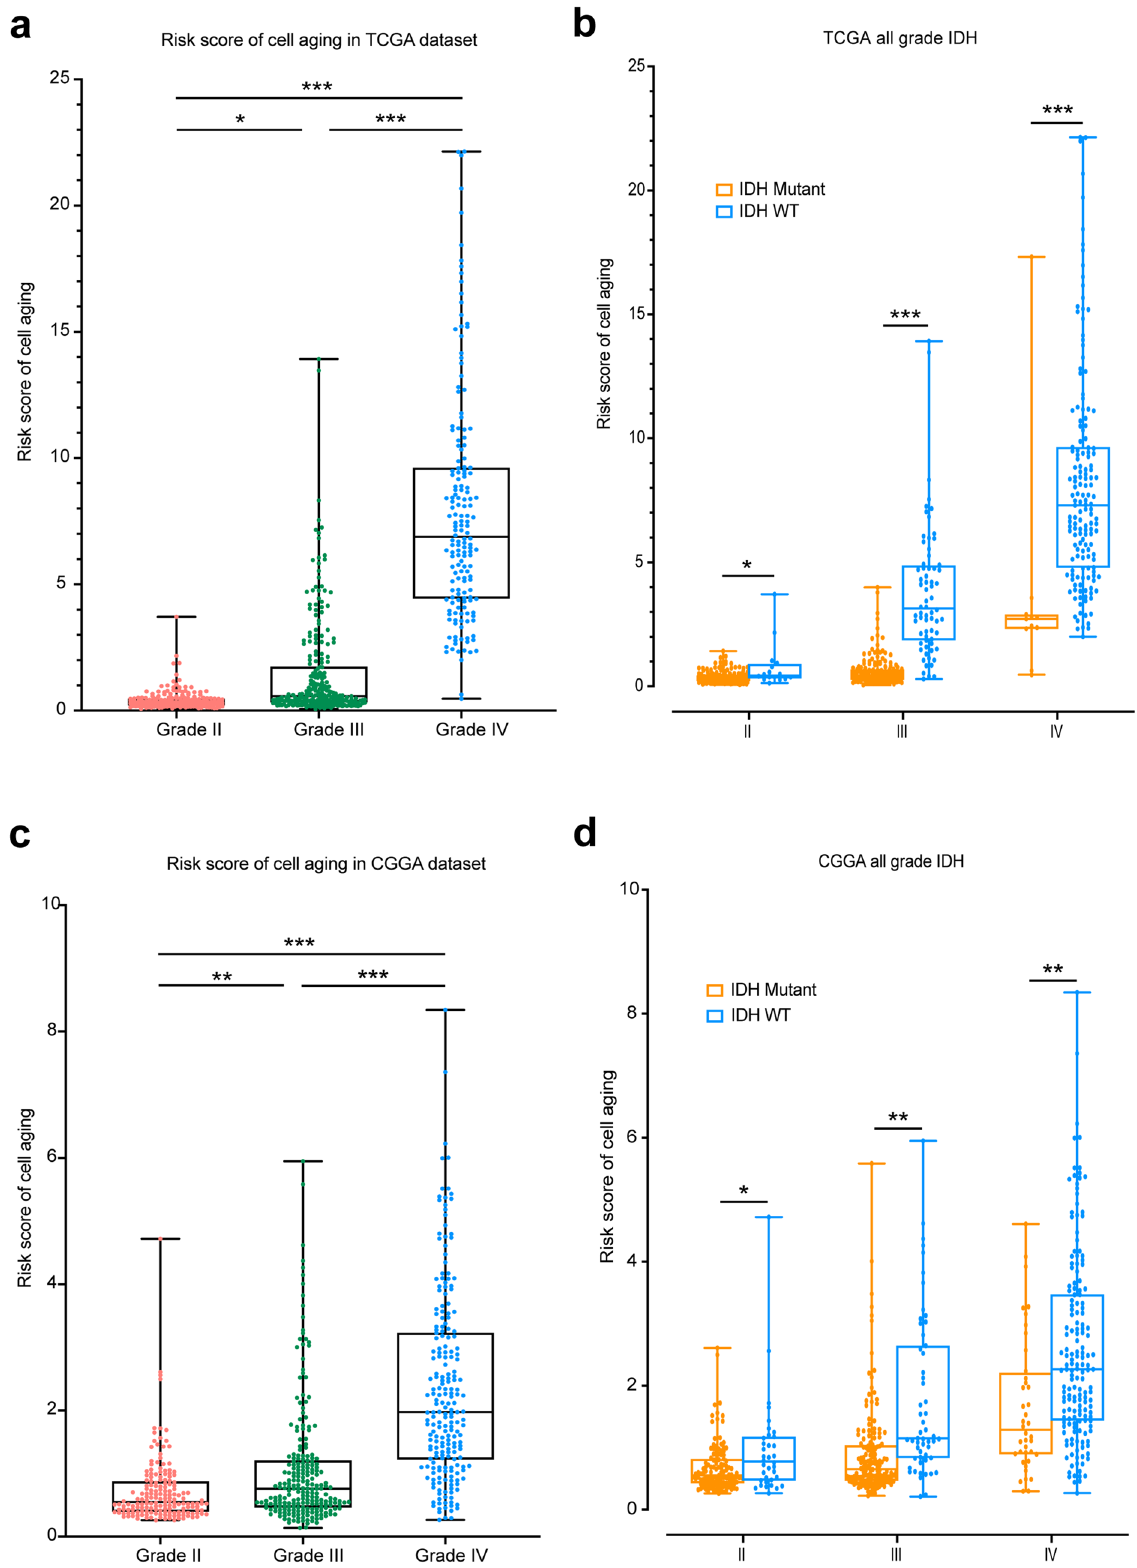
Figure 4. Risk score of the signature and relationship between risk score and IDH mutation in the TCGA and CGGA data sets. Risk score of the signature in the TCGA ( a ) and CGGA ( c ) data sets according to WHO grade. Relationship between risk score and IDH mutation in the TCGA ( b ) and CGGA ( d ) data